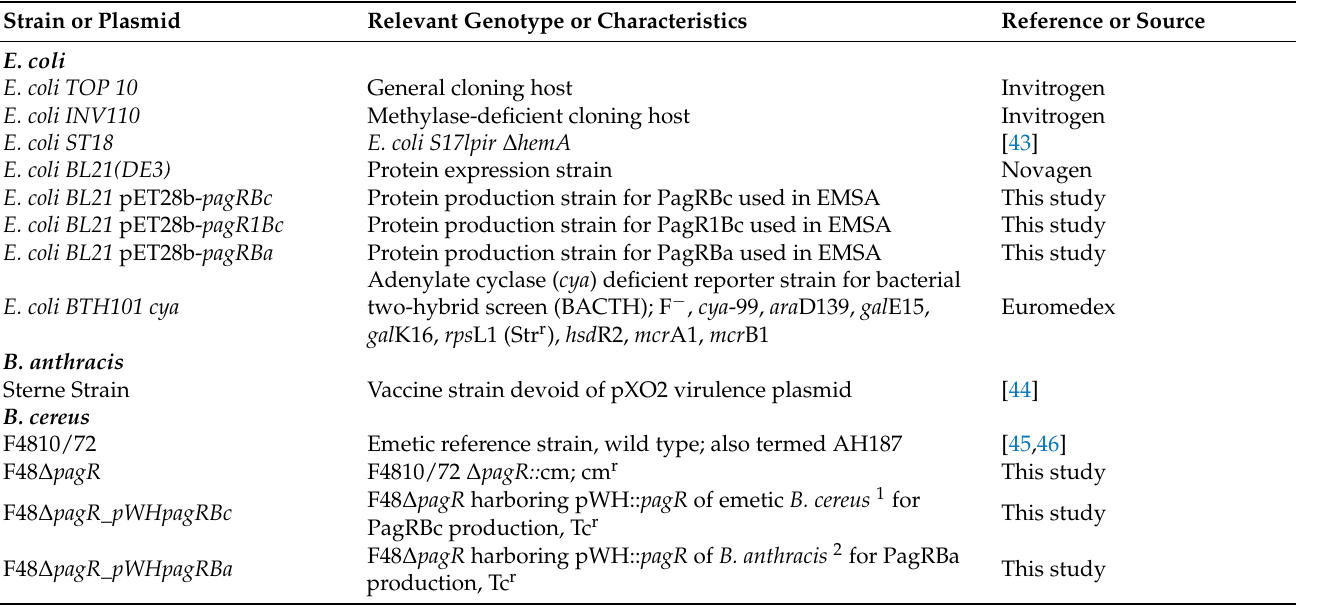
Table 1. Bacterial strains used in this